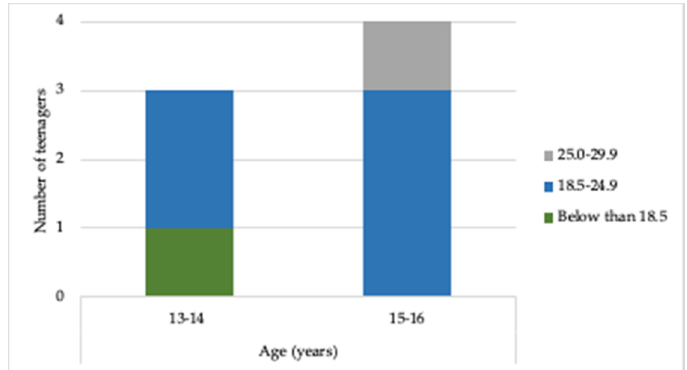
Figure 3. Distribution of students by age and Body Mass Index (BMI).